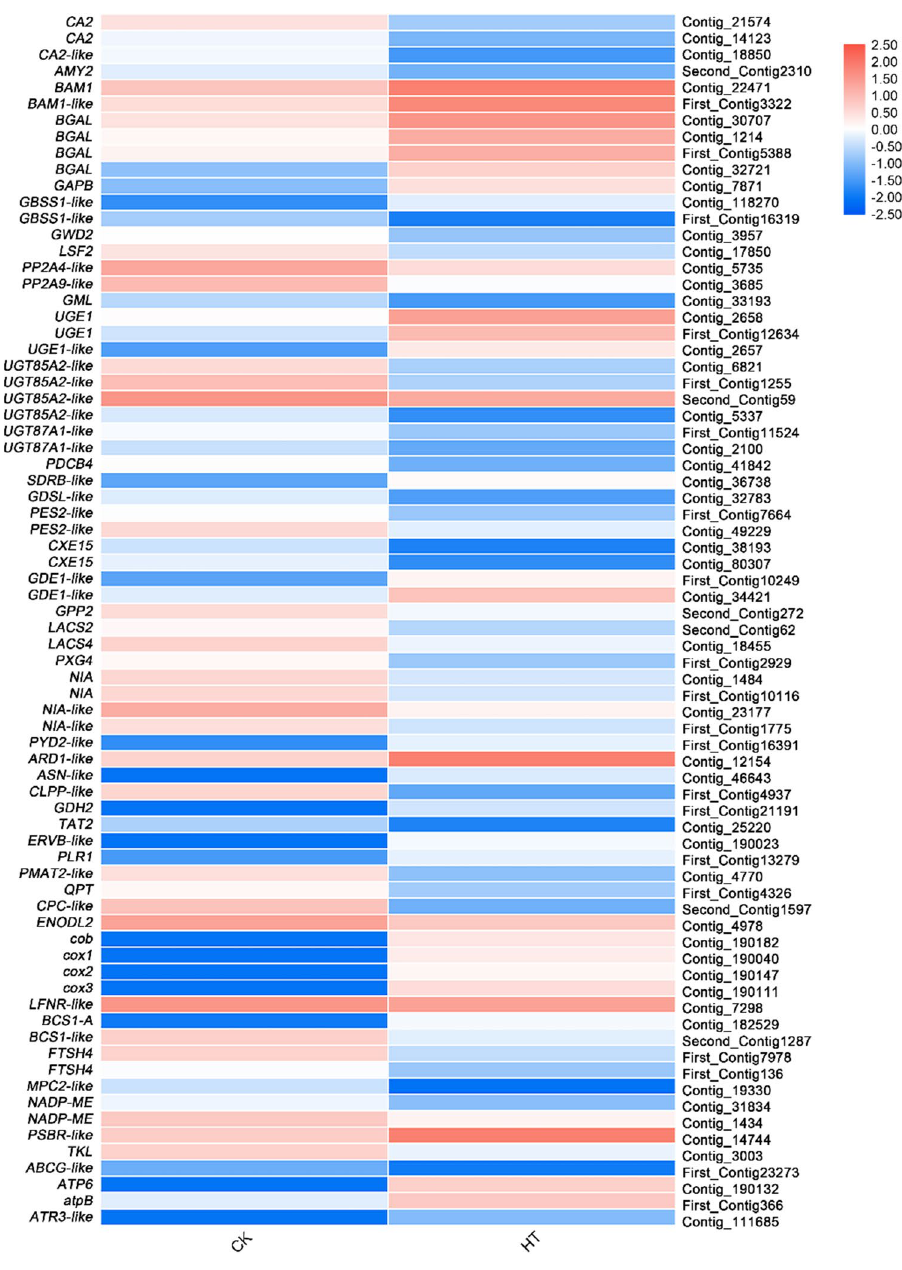
Figure 9. Relative expression levels of DEGs related to metabolism process. The rows in the heat map represent the individual gene IDs, and the columns represent the samples taken from high-temperature treatment (HT) and control (CK). The changes in expression are indicated by colors ranging from blue (down-regulated) to yellow red